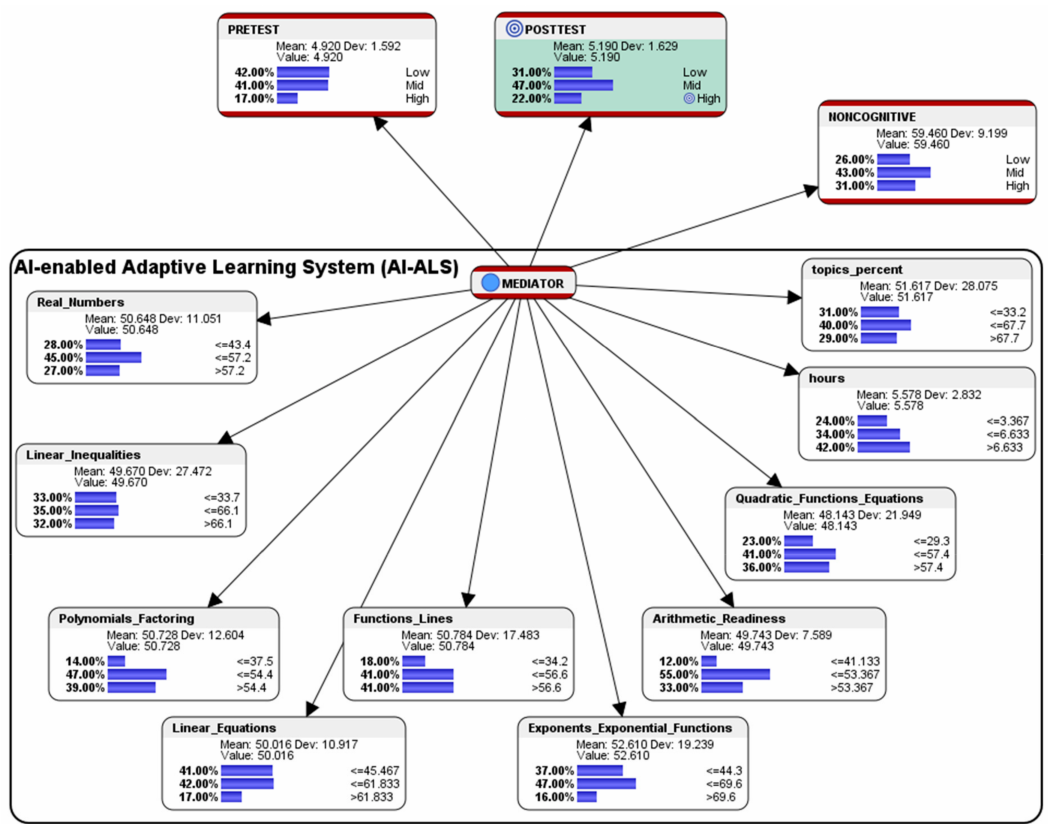
Figure 2. Simplified aggregated view of the Bayesian network previously shown in Figure 1, presenting only the superordinate factor nodes with their machine-learned score-clusters, depicting the overall performance levels of all 100 students who had used the five dissimilar AI-ALS from five di ff erent